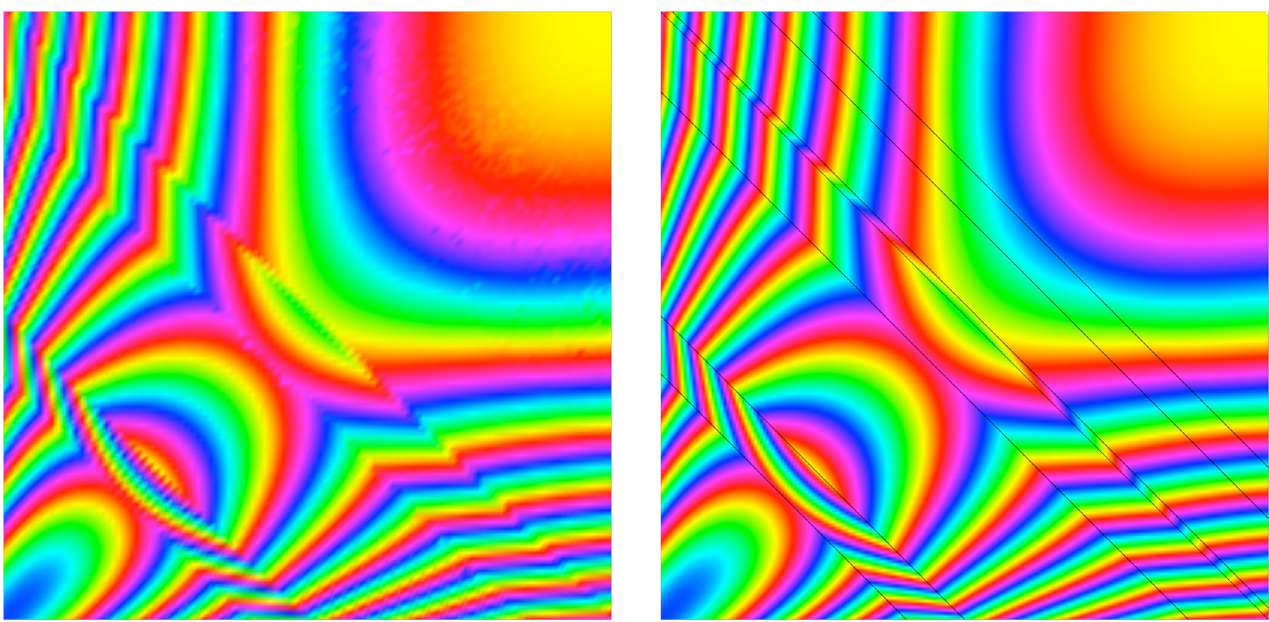
FIG. 14 Contours of optimal packing density ϕ for the 323 · 1 family, numeric (left) versus analytic (right). The color gradient {blue, magenta, red, yellow, green, cyan, and blue} represents the ϕ gradient f ϕ − 3 ϕ þ 3 ; yellow contours occur at ϕ ¼ f 4 60 g